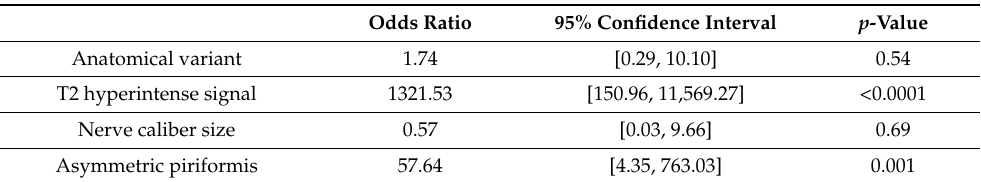
Table 6. Odds ratio and 95% confidence interval of imaging characteristics as predictors, and symptoms as outcome.